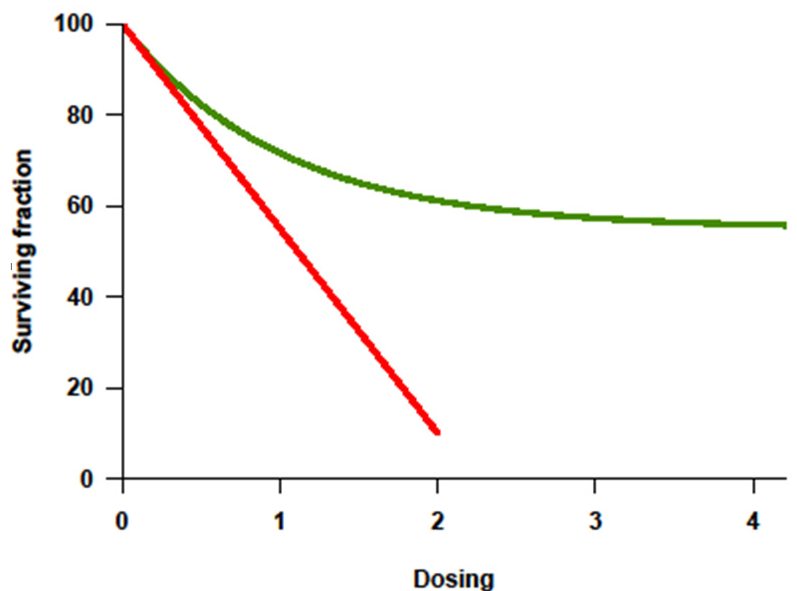
Figure 1. Dose–response curve showing log-fold increase in cell killing ( Y -axis = survivor cells) with increase in dosage ( X -axis) as the basis for high-dose therapy strategies. Adapted from original in Frei E III, Canellos GP: Dose: A critical factor in cancer chemotherapy. Am J Med 69:585–594, 1980. [9].